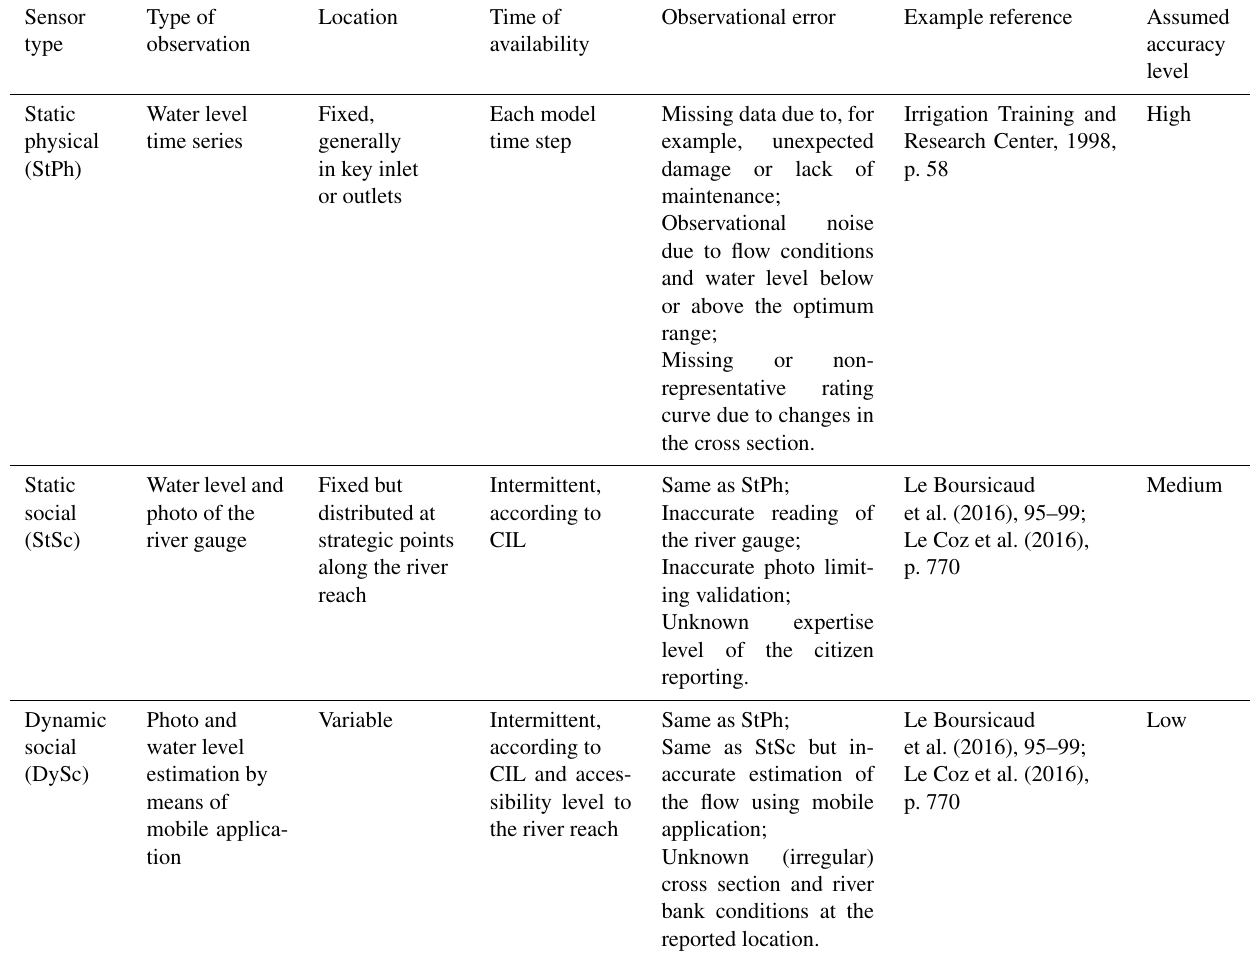
Table 1. General characteristics of the type of observations based on sensor